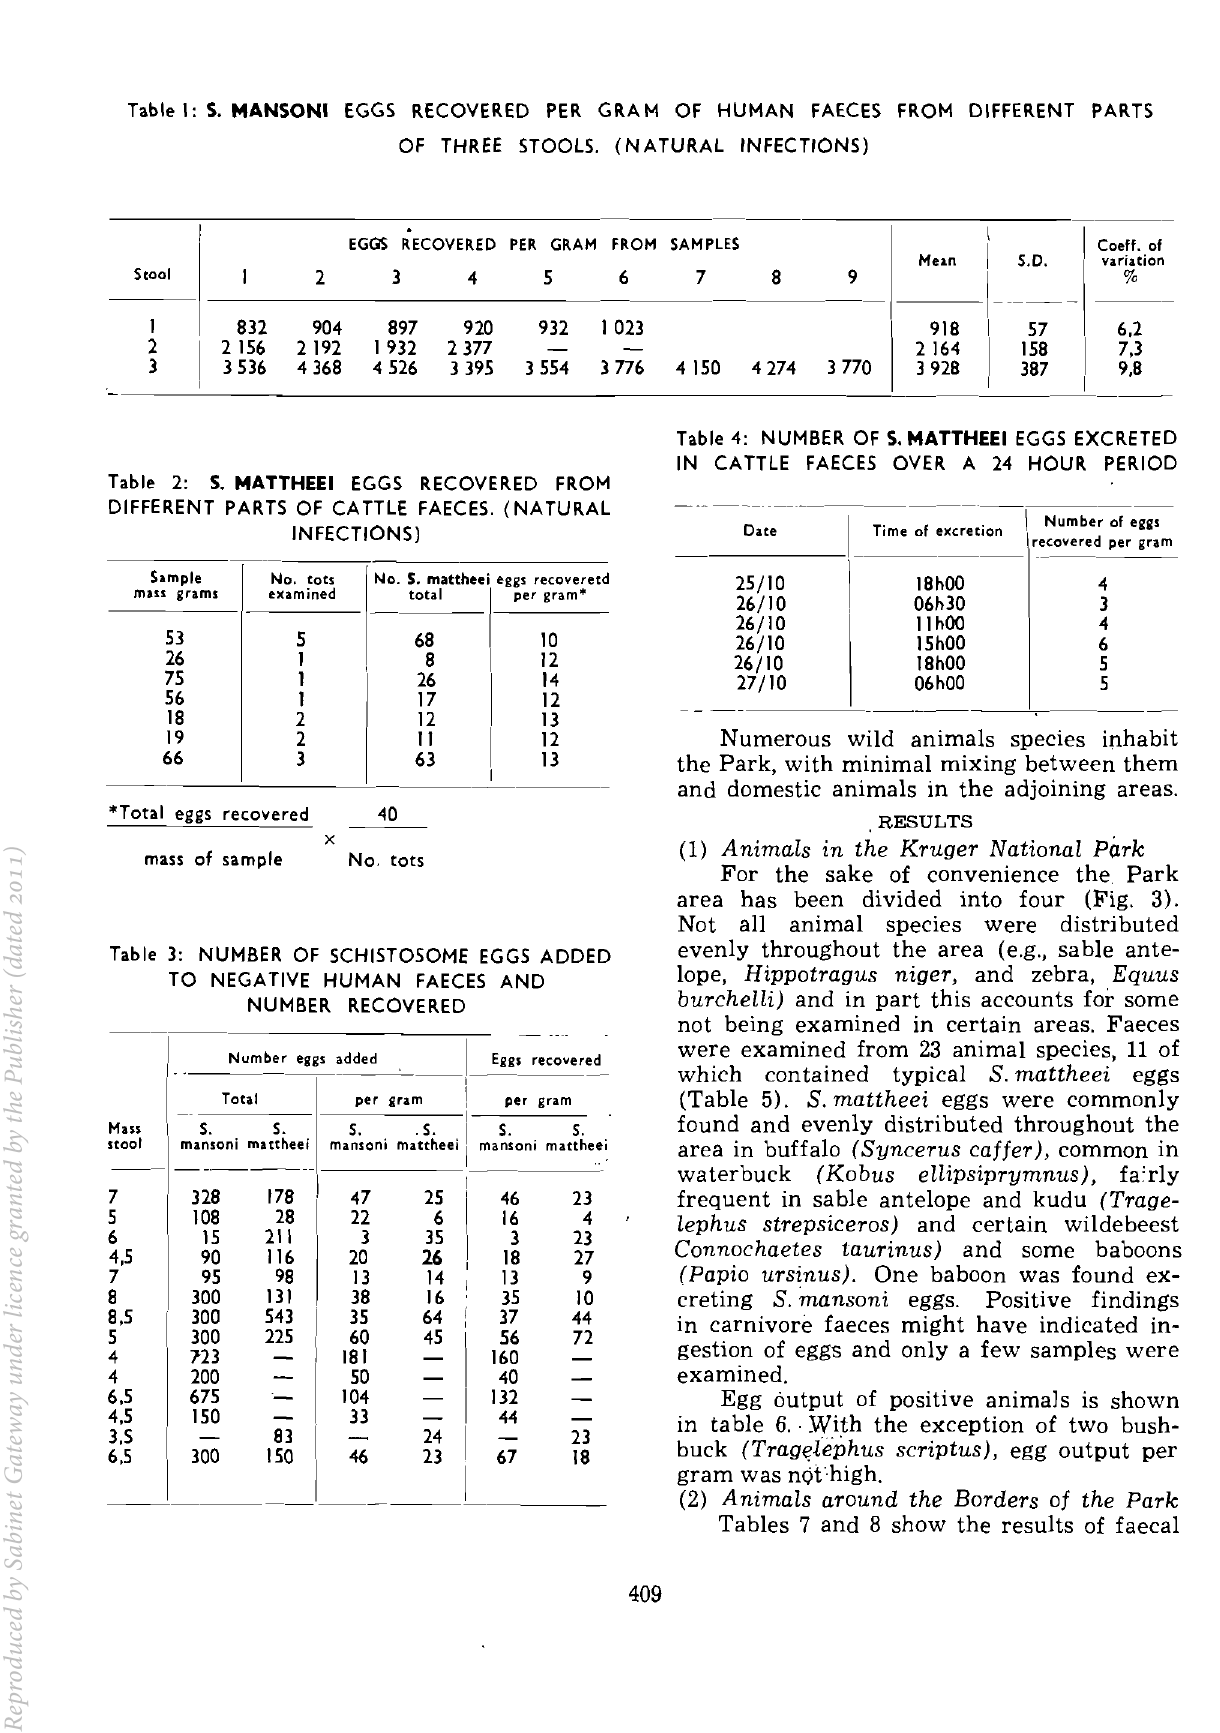
Table I: S. MANSONI EGGS RECOVERED PER GRAM OF HUMAN FAECES FROM DIFFERENT PARTS OF THREE STOOLS. (N A TURAL INFECTIONS)